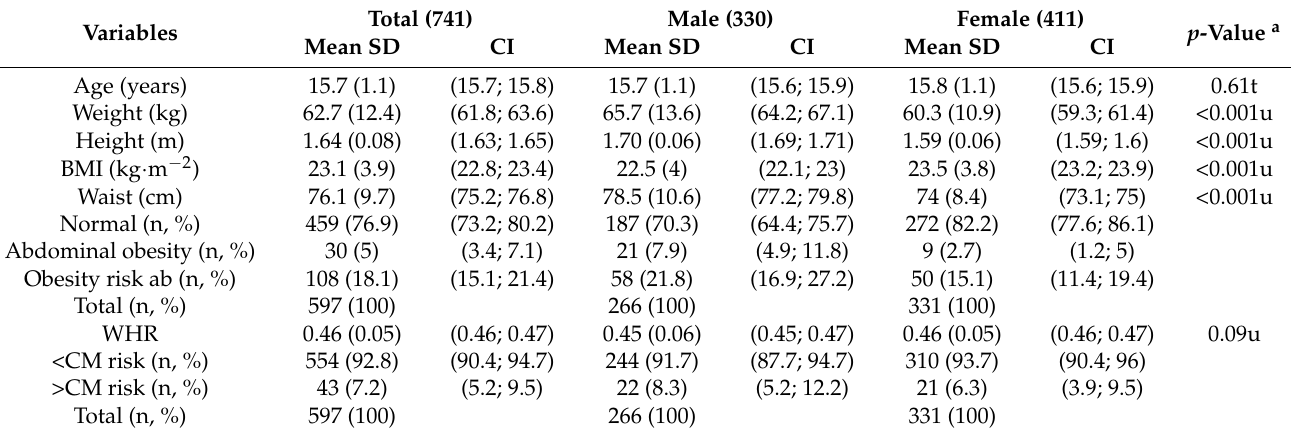
Table 1. Basic anthropometry of